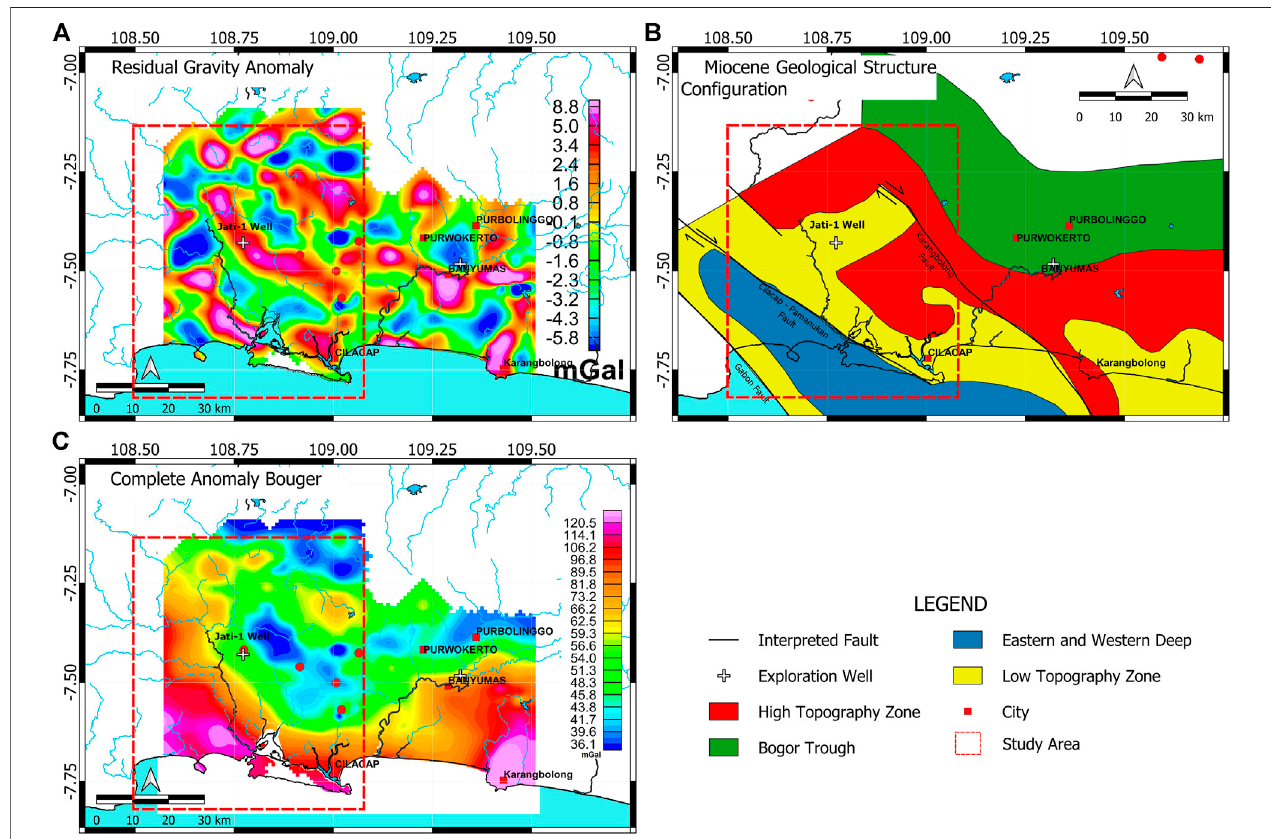
FIGURE6| Previousstudiesavailableforthestudyareawereusedforcomparisonwithourhorizontalcrosssectionresults: (A) Aresidualgravityanomaly(modi fi ed from Hidayat et al., 2020), (B) the regional Miocene geological structure con fi guration of the southern part of Central Java (modi fi ed from Muchsin et al., 2002), and (C) the complete Bouger anomaly map (modi fi ed from Hidayat et al., 2020).